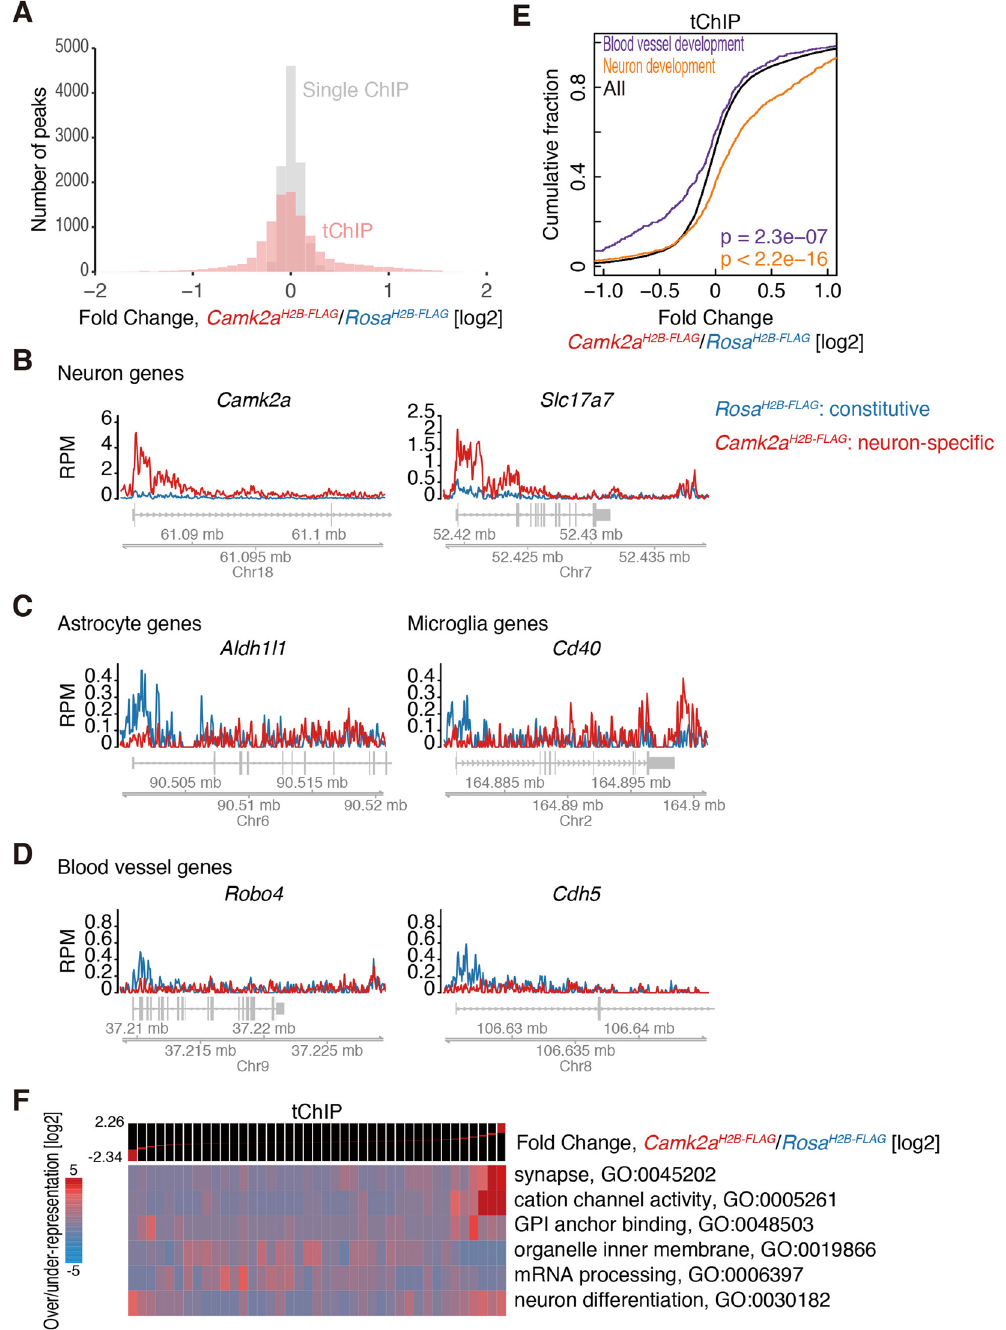
Figure 3. tChIP-Seq from Camk2a H2B-FLAG showed accumulation and depletion of reads along known neuronal genes and non-neuronal genes, respectively. ( A ) Histogram of number of peaks along differential changes of single H3K4me3 ChIP-Seq and tChIP-Seq in Camk2a H2B-FLAG compared to those from Rosa H2B-FLAG . Bin width is 0.1. ( B – D ) Distribution of reads from tChIP-Seq of Rosa H2B-FLAG and Camk2a H2B-FLAG along each gene locus. RPM: reads per million. ( E ) Cumulative distribution of reads in peaks corresponding to neuron development and blood vessel development genes along differential changes between Camk2a H2B-FLAG and Rosa H2B-FLAG tChIP- Seq. Significance is calculated by Mann-Whitney U test. ( F ) GO analysis along differential changes between Camk2a H2B-FLAG and Rosa H2B-FLAG tChIP-Seq with